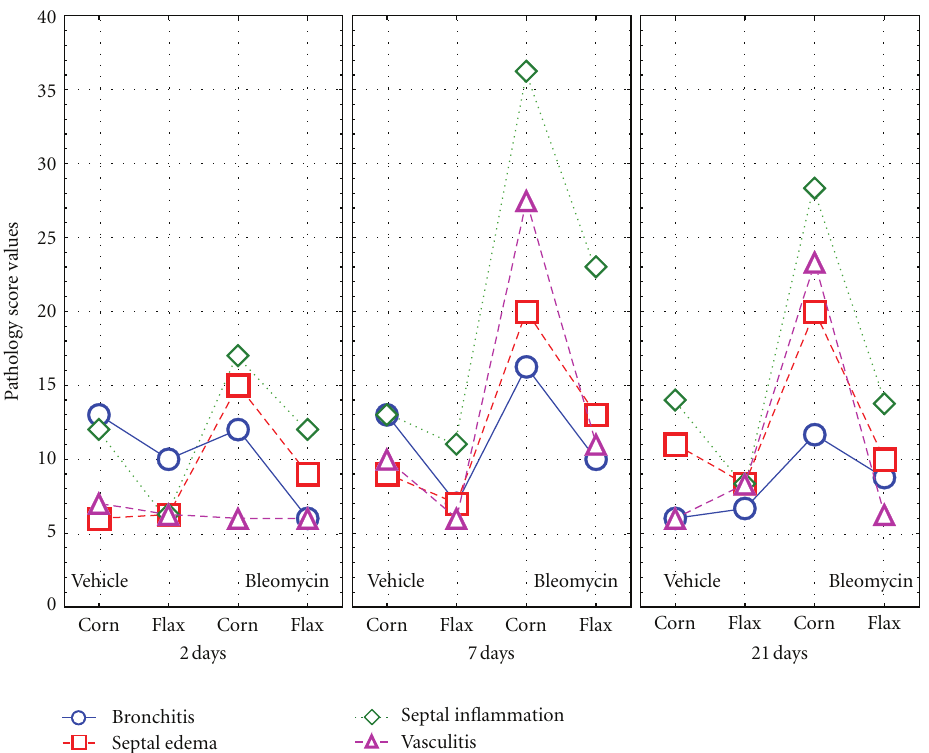
Figure 4: Qualitative evaluation of the pathological scores of the various treatment groups at each time interval point. (Staining: H&E). The symbols represent the mean of all the rats in each